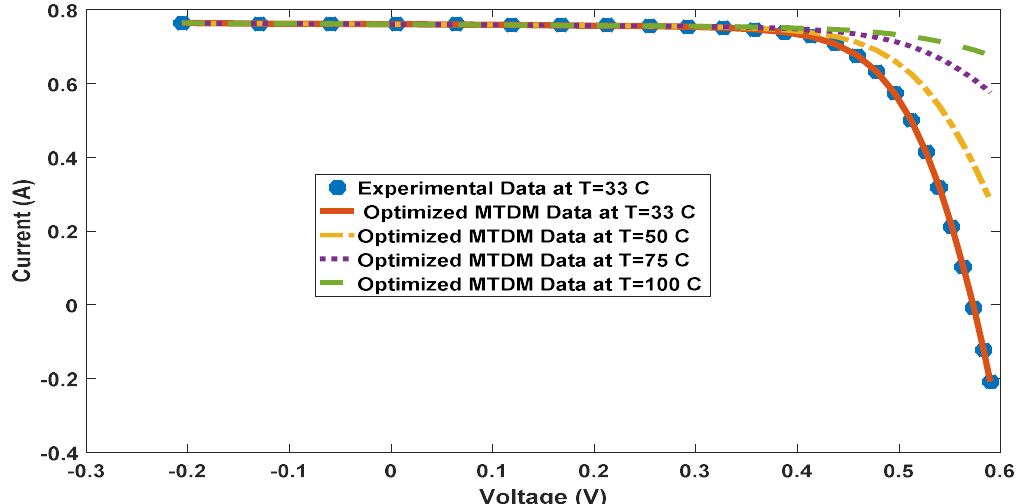
Figure 16. Current–voltage characteristic curve comparison between experimental current and TDM current estimated by WHO at different temperatures.